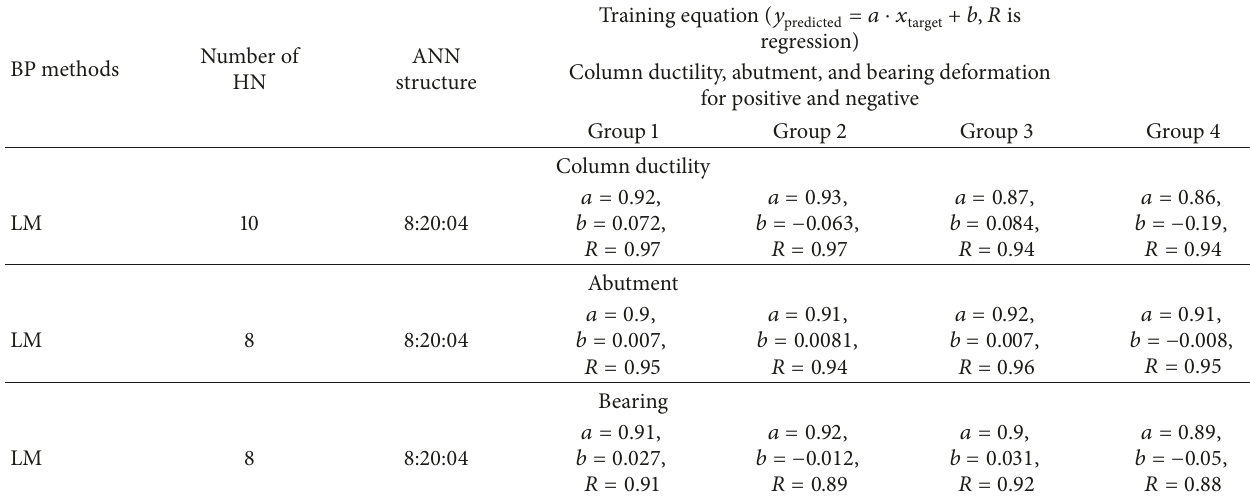
Table 7: Prediction of response structure by NN including all seismic scales, in training step for bridge elements (Approach